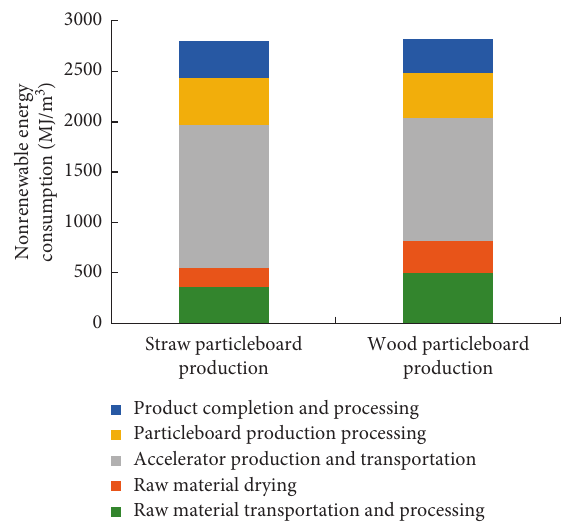
Figure 4: Contribution of particleboard production process to nonrenewable energy consumption.